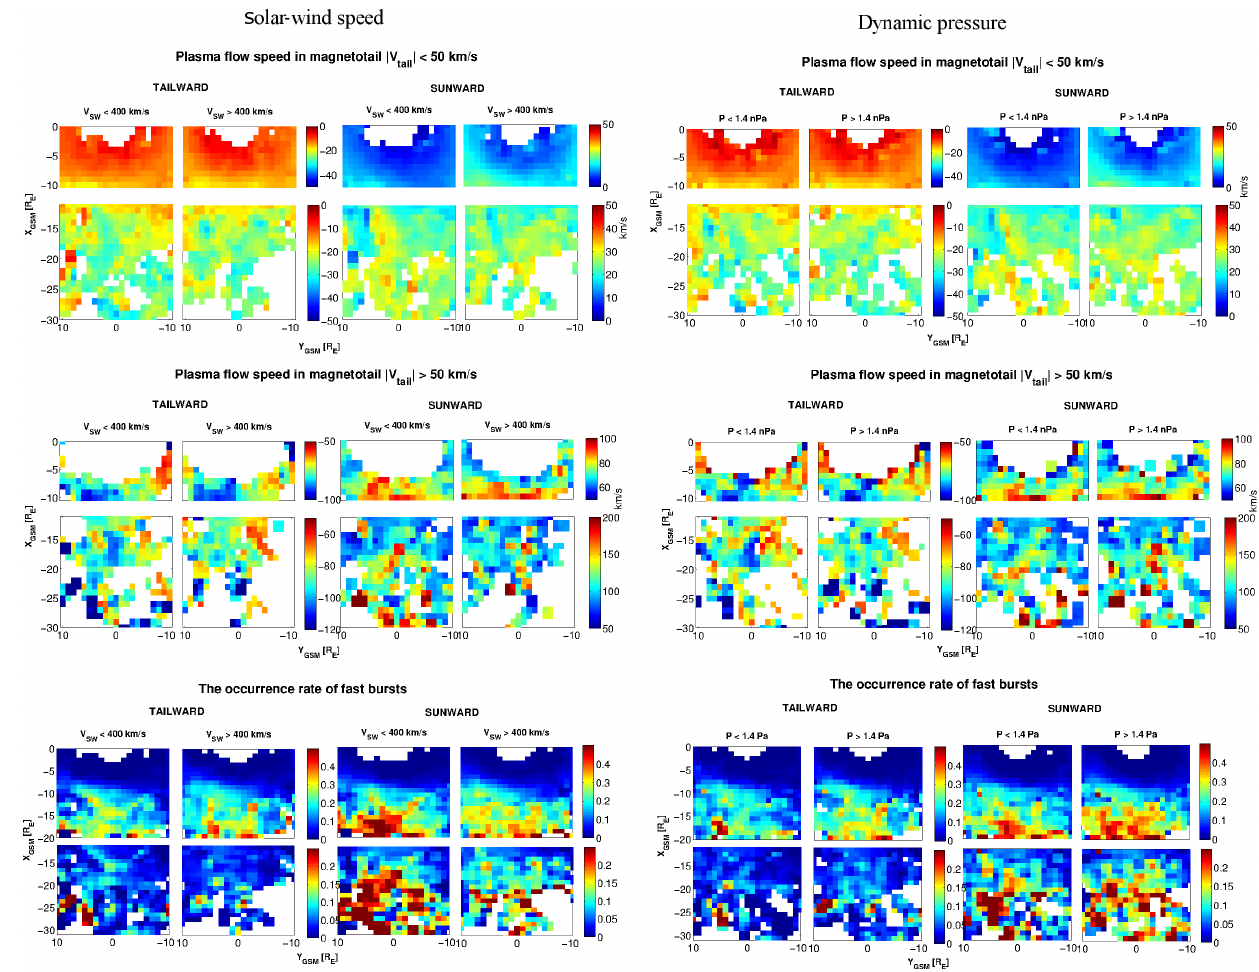
Figure 6. Average plasma flow pattern for slow ( | V tail | < 50kms − 1 , top panels) and fast flows ( | V tail | > 50kms − 1 , middle panels), ratio between the time steps when tail flow bursts exceeded 50kms − 1 (bottom panels, region 0 >X> − 20 R E ) or 100kms − 1 (bottom panels, region − 20 >X> − 30 R E ), and all time steps when the data points are divided into groups based on the solar-wind speed and dynamic pressure. The limit for the 1h sliding average solar-wind speed and pressure values are written above the maps. The tailward and sunward flows are shown